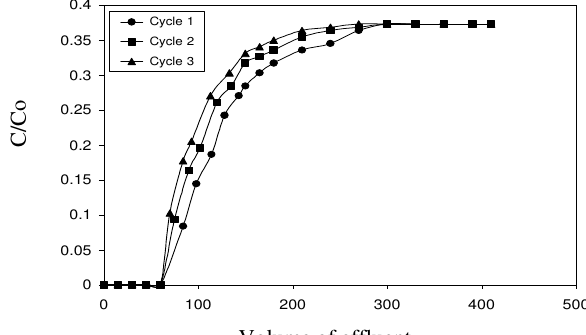
Figure 10 . Break through curves for adsorption of Cr(VI) on trametes versicolor olyporous